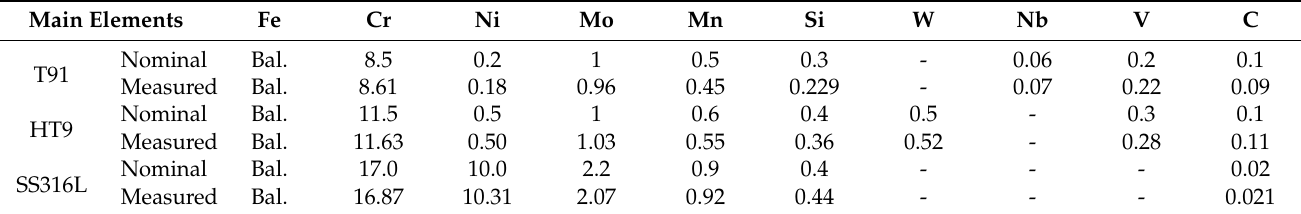
Table 1. Elemental compositions of tested materials (in